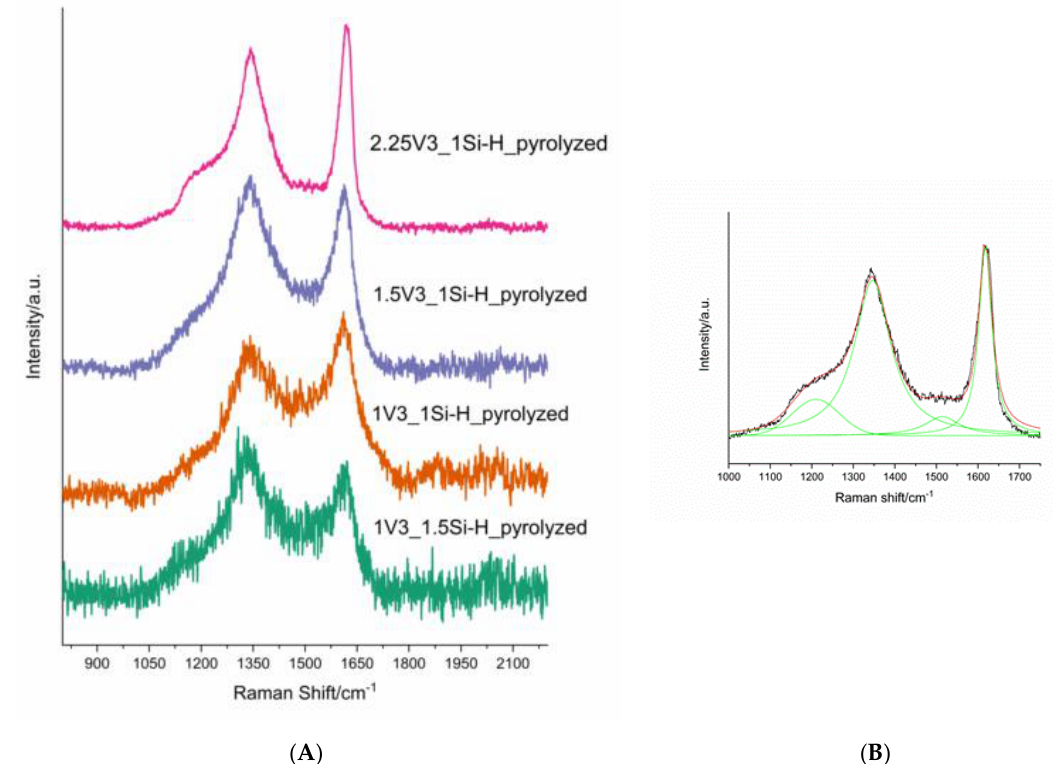
Figure 3. ( A ) Raman spectra of the pyrolyzed polyHIPEs; ( B ) deconvoluted Raman spectrum of the 2.25V3_1Si-H pyrolyzed sample.